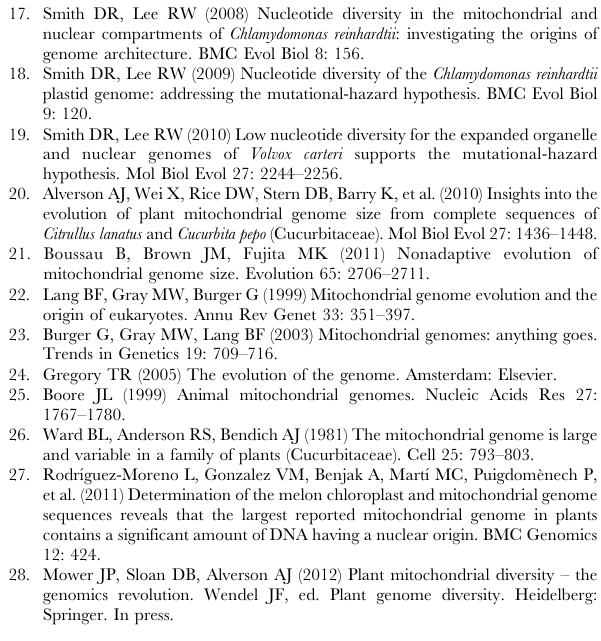
Table S1 Duplicate genes in Silene mitochondrial genomes. Values indicate cases where more than one full-length